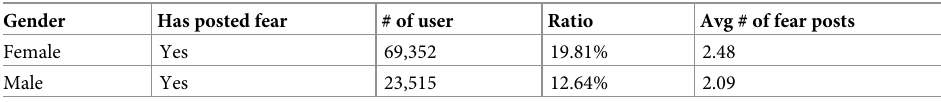
Table 3. Gender statistics on fear expression. Gender Has posted